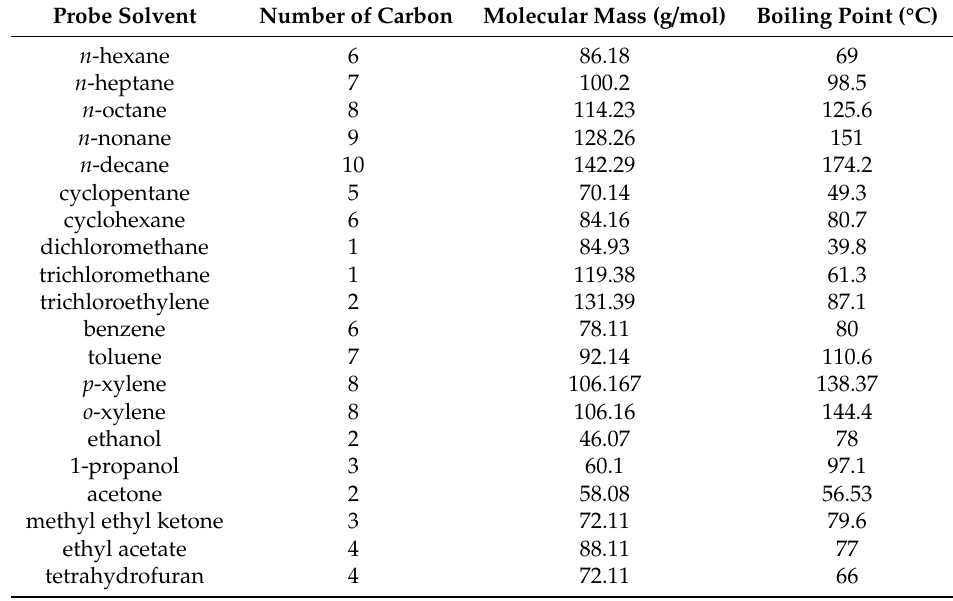
TableA1. Physicalpropertyparametersofsmallmoleculeprobesolventsbyinversegaschromatography